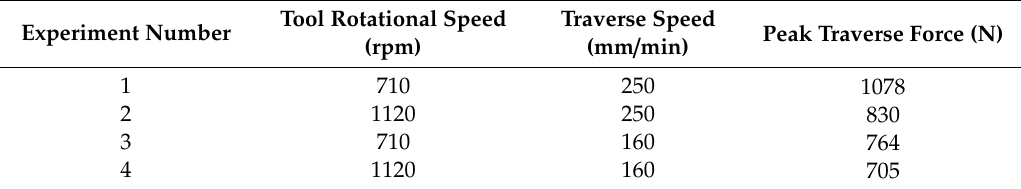
Table 7. Experimental values for ANOVA.